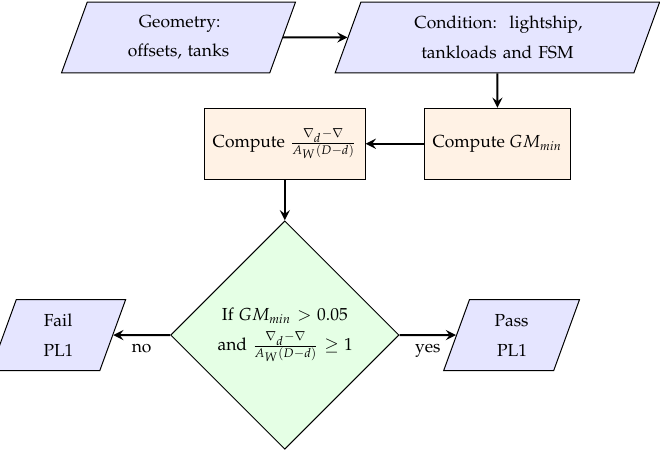
Figure 9. Pure Loss Level 1 algorithm process